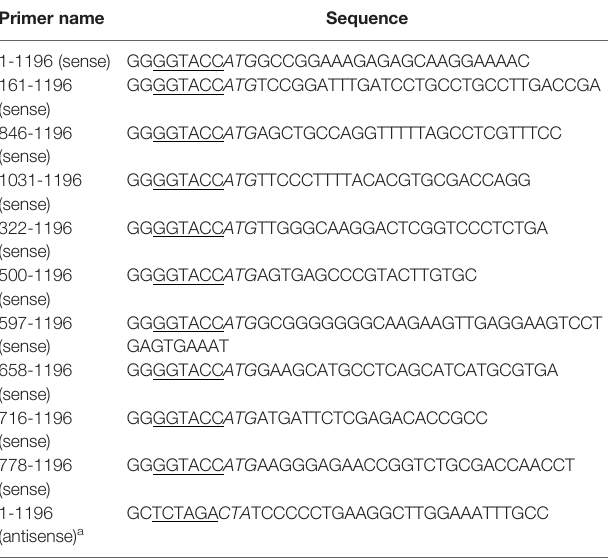
TABLE 2 | Primers for truncated sequence of HP-PRRSV NSP2.